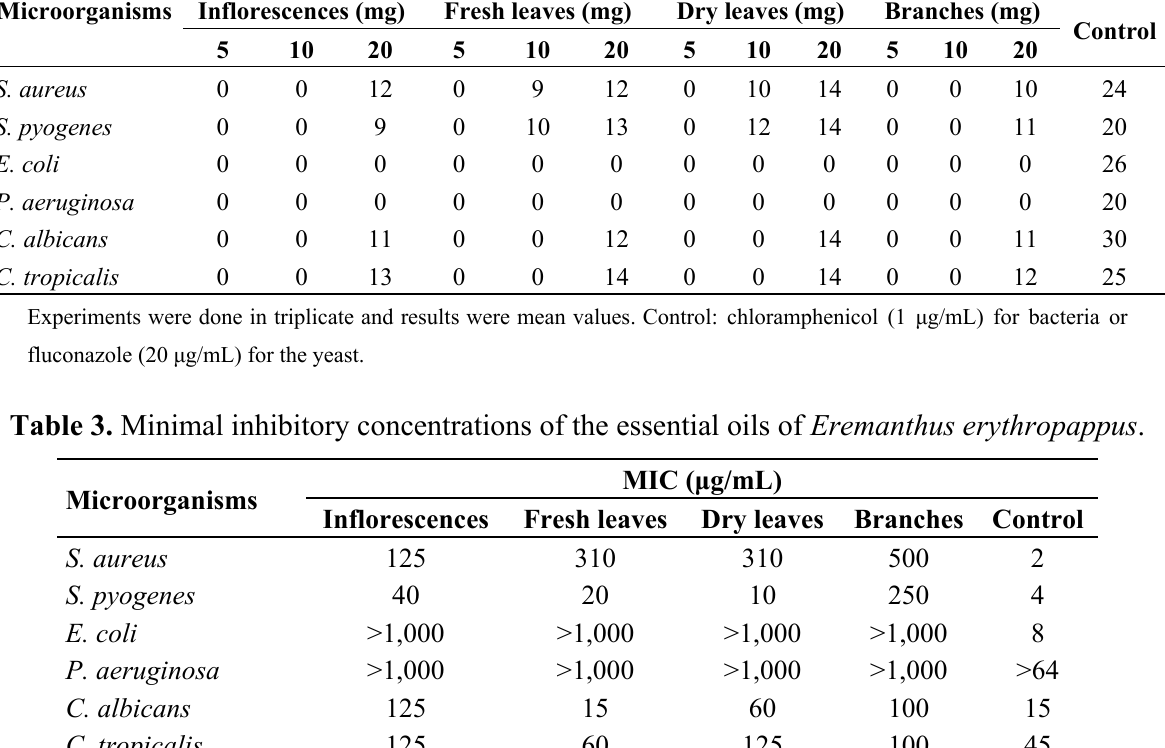
Table 2. Antimicrobial activity of the essential oils of Eremanthus erythropappus . Microorganisms